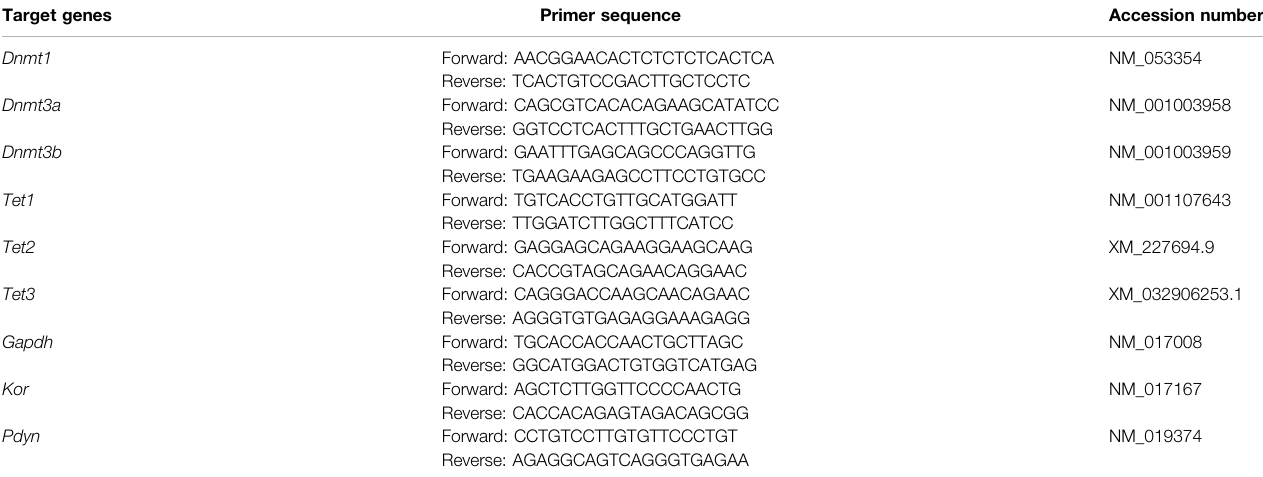
TABLE 1 | qPCR primer sequences for the gene expression assay.